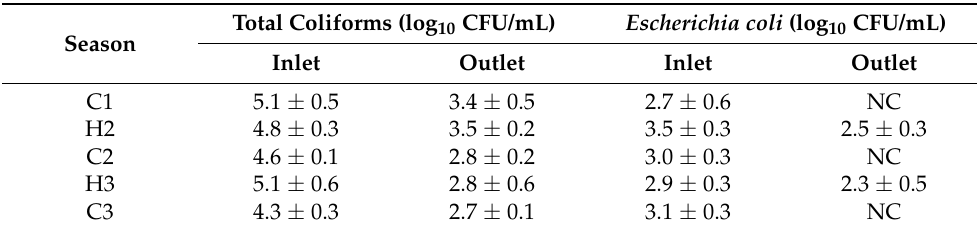
NC: no viable counts.